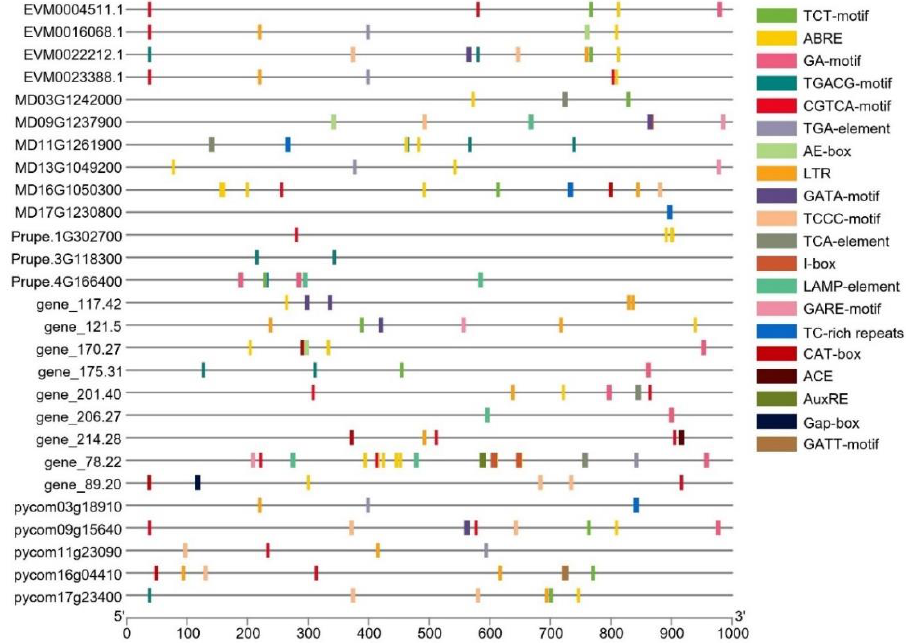
Figure 4. The cis -regulatory elements detected in the promoter sequences of PEPC genes in five Rosaceae